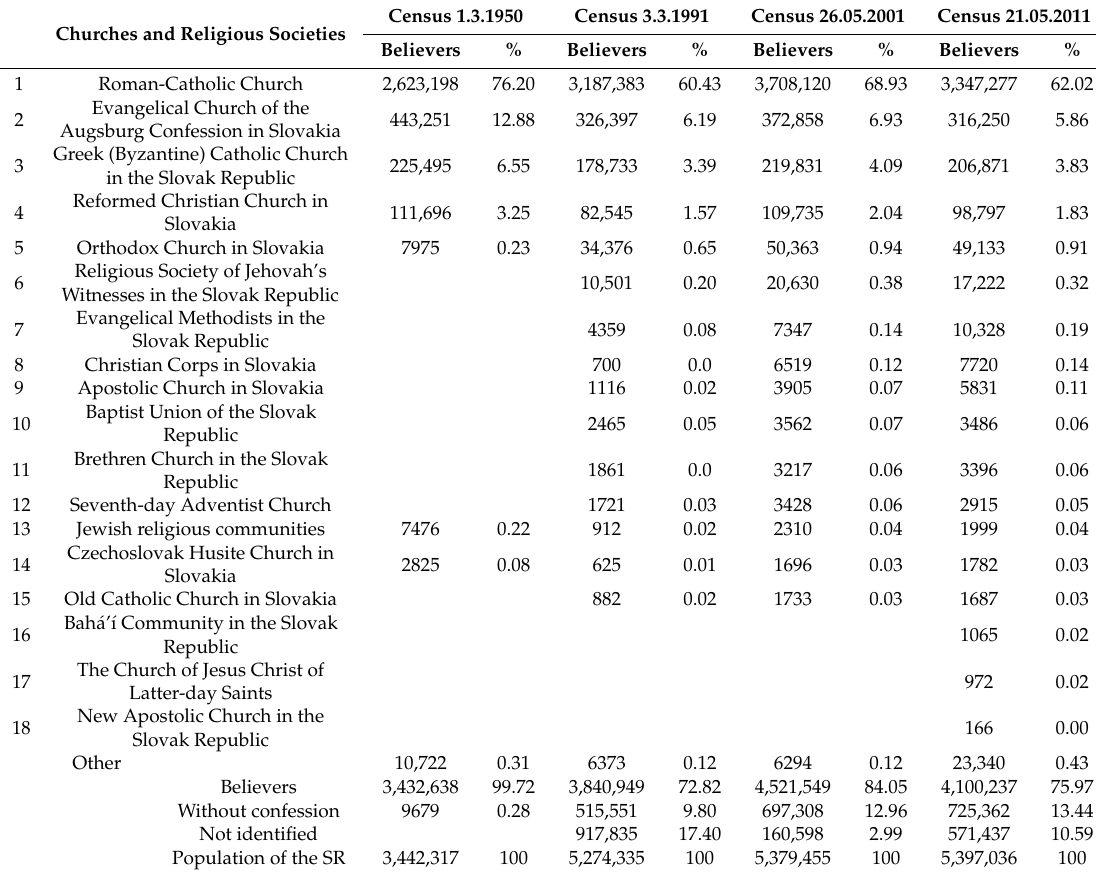
Table 1. Numbers of believers in Slovakia